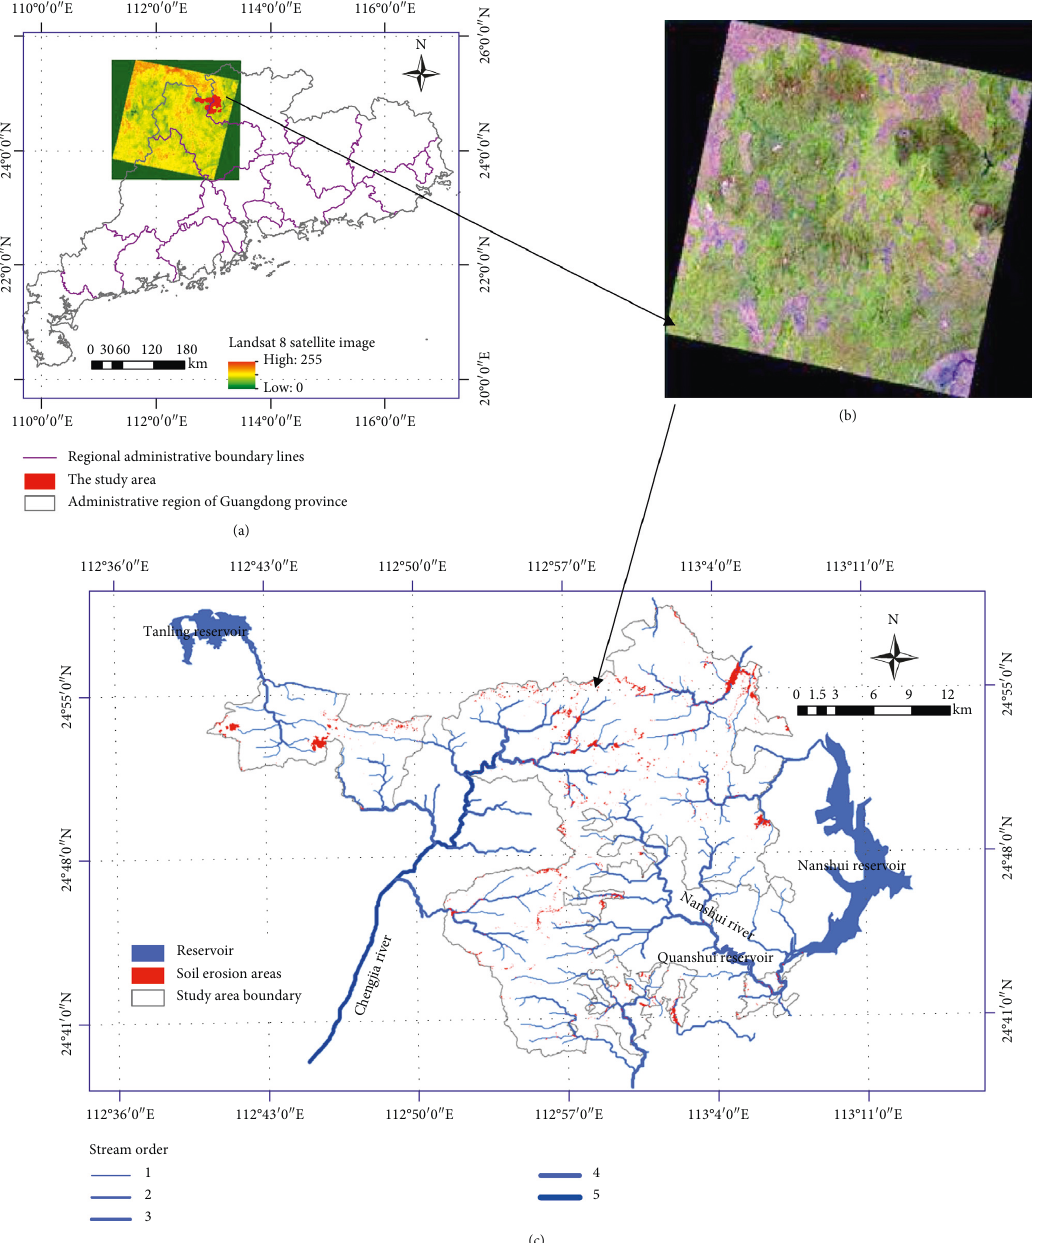
Figure 6: The Landsat 8 remote sensing image and the soil erosion distribution in NNNR: (a) The location map of Landsat 8 remote sensing image, (b) the Landsat 8 image, and (c) the distribution of soil erosion in NNNR. This figure is reproduced from Wang et al. [28] (under the Creative Commons Attribution License/public